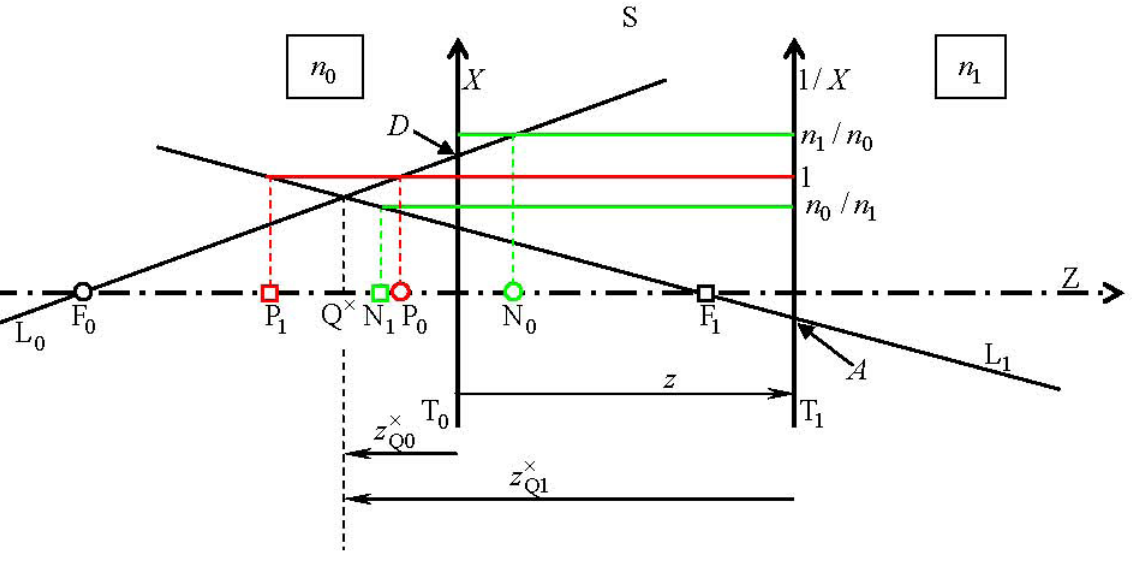
Figure 3 The locator lines L 0 and L 1 for system S. They represent Equations 6 and 7 respectively. Axis X is superimposed on en- trance plane T 0 and axis 1/ X on exit plane T 1 . L 0 intersects T 0 in D and the optical axis Z at the incident focal point F 0 . L 1 intersects T 1 in A and Z at the emergent focal point F 1 . The principal (red) and nodal (green) points are shown. The locator lines intersect in a point corresponding to × Q on Z with longitudinal position given by Equation 8. Incident and emergent points are represented by means of circles and squares